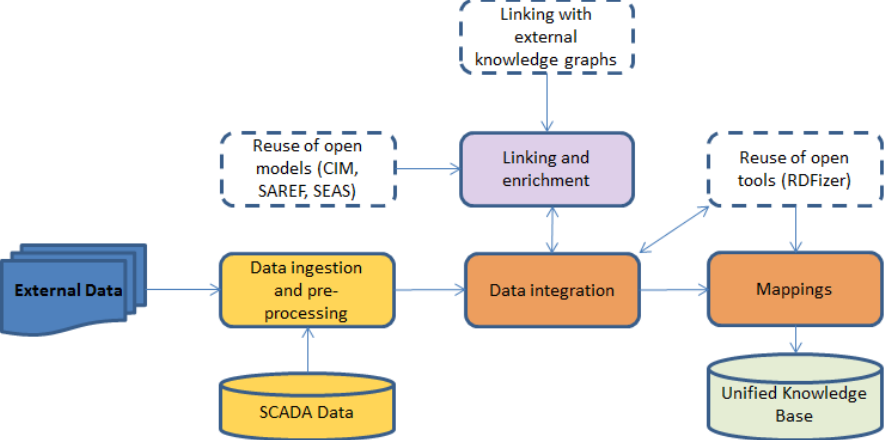
Figure 6. Unified knowledge graph creation